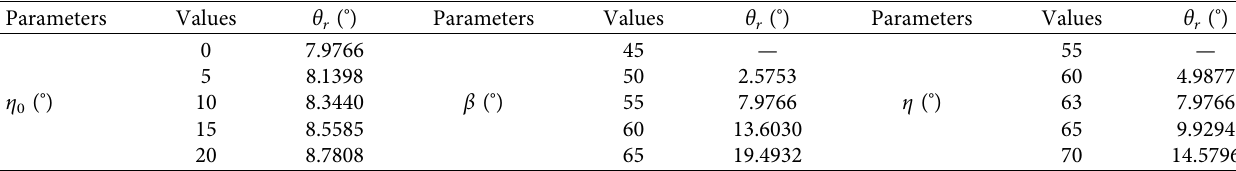
Note . “—” indicates that the slope is stable.